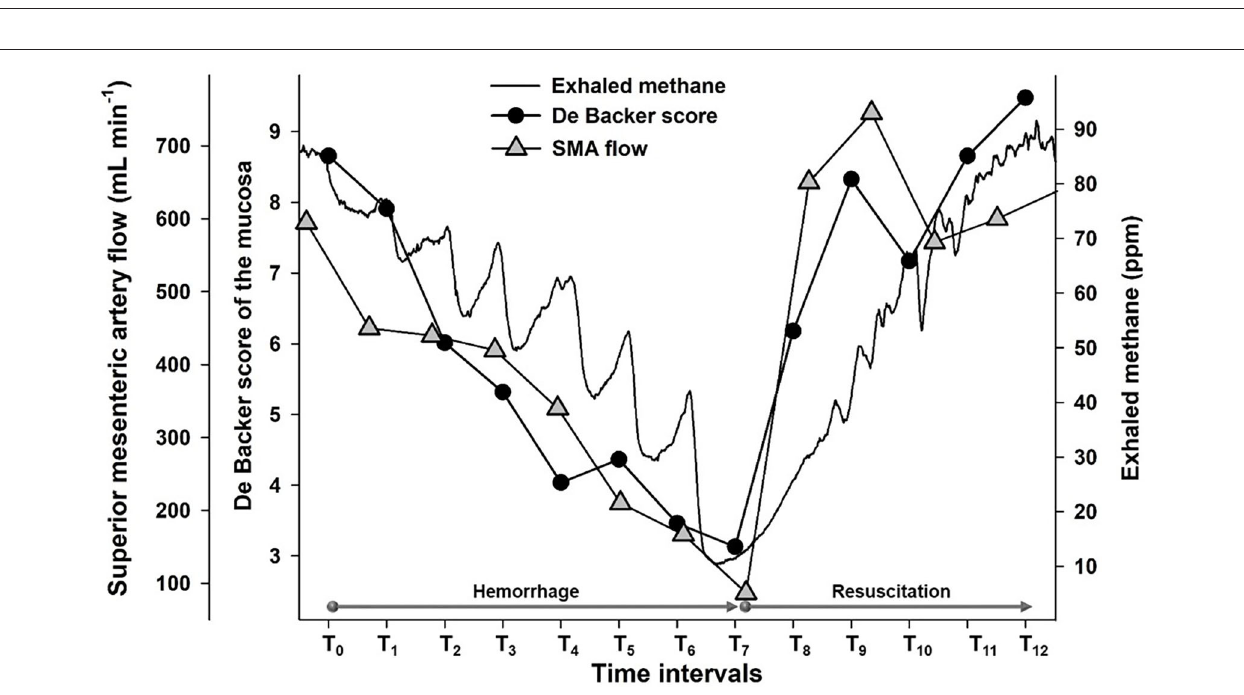
FIGURE 7 | Original tracings representing changes in exhaled methane levels (ppm) (continuous black line), the De Backer score (1 mm − 1 ) for ileal mucosa (black circles) and superior mesenteric artery flow (ml min − 1 ) (gray triangle) of an individual